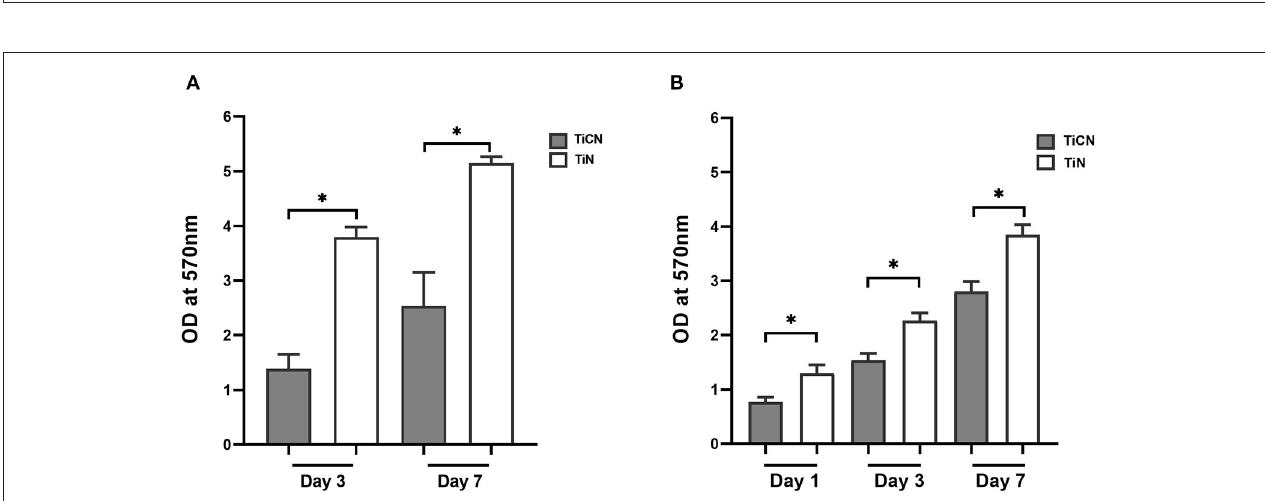
FIGURE 3 | Biomass determination of oral microbial biofilm formed on the surfaces of TiCN- and TiN-coated discs using the crystal violet assay. Shown are the biomass of the biofilms formed on TiCN (gray bars) and TiN (yellow bars) in 50% SHI medium (A) without Scr and Man supplementation, and (B) in the presence of Scr and Man. *indicates significant differences of p < 0.05.